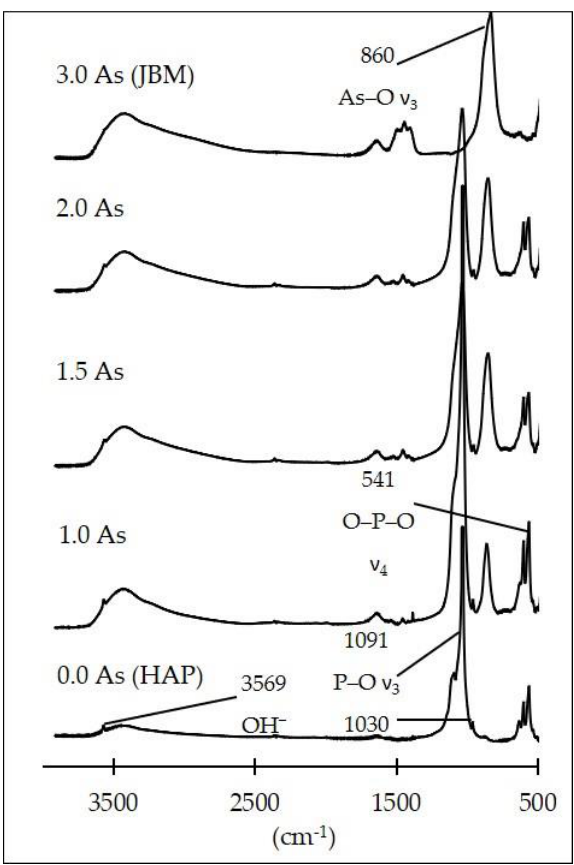
Figure 6. Fourier-transform infrared spectroscopy (FTIR) spectra of the JBM–HAP solid solution series.